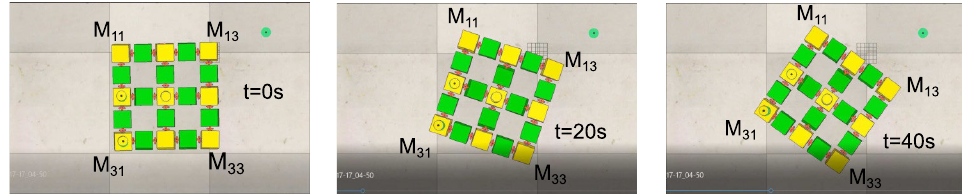
Fig. 14 Spinning locomotion of WORMESH-II for IMF in simulation (wave parameters are A = 0.05 π , ω = π , and β = 4 π/ 3 )